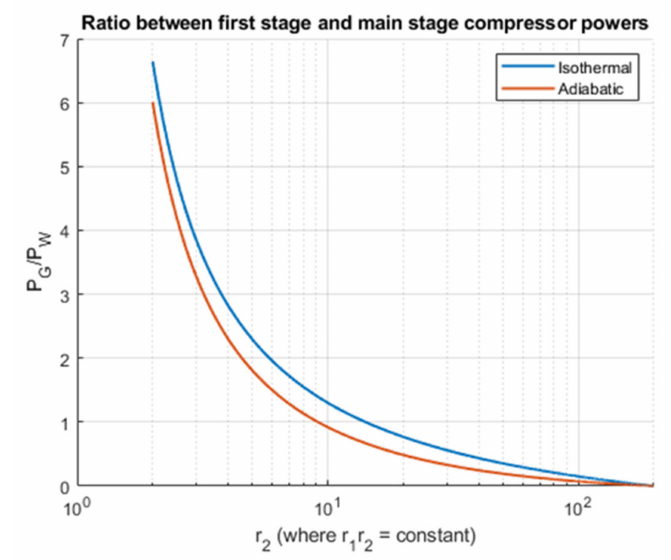
Figure 5. Power ratios for an isothermal and an adiabatic main stage of compression, where the upper pressure, r 1 r 2 , is